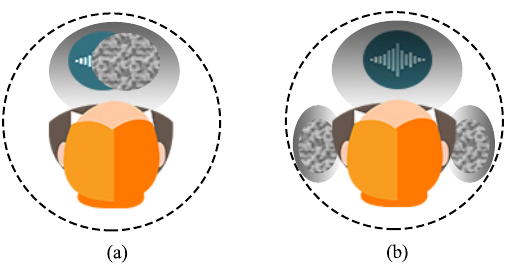
Figure 12. The average auditory map marked by the listening subjects: ( a ) monaural superdirective beamformer and ( b ) binaural superdirective beamformer. The blue waves refer to the region in which the desired speech is heard, and the region filled with disorderly dots refer to the region in which the white noise is heard. Conditions of experiment: M = 8, N = 4, and δ = 1.1